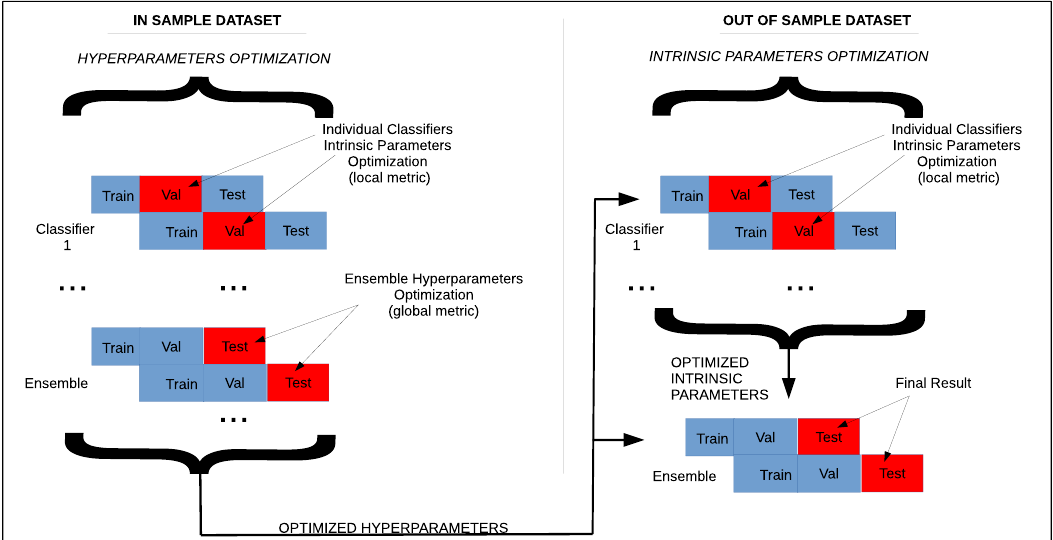
Figure 1. The proposed two-step auto adjustable parameters ensemble for market forecasting. This approach optimizes two sets of parameters for a final ensemble to trade in any market. Firstly, in an in-sample dataset with late past data, we optimize the hyperparameters, considering performance metrics in the testing part of data. Then, these hyperparameters are transferred to create ensembles for an early past (out of sample) dataset. The individual classifiers have their intrinsic parameters updated in the validation part of this recent data and then the final ensemble is